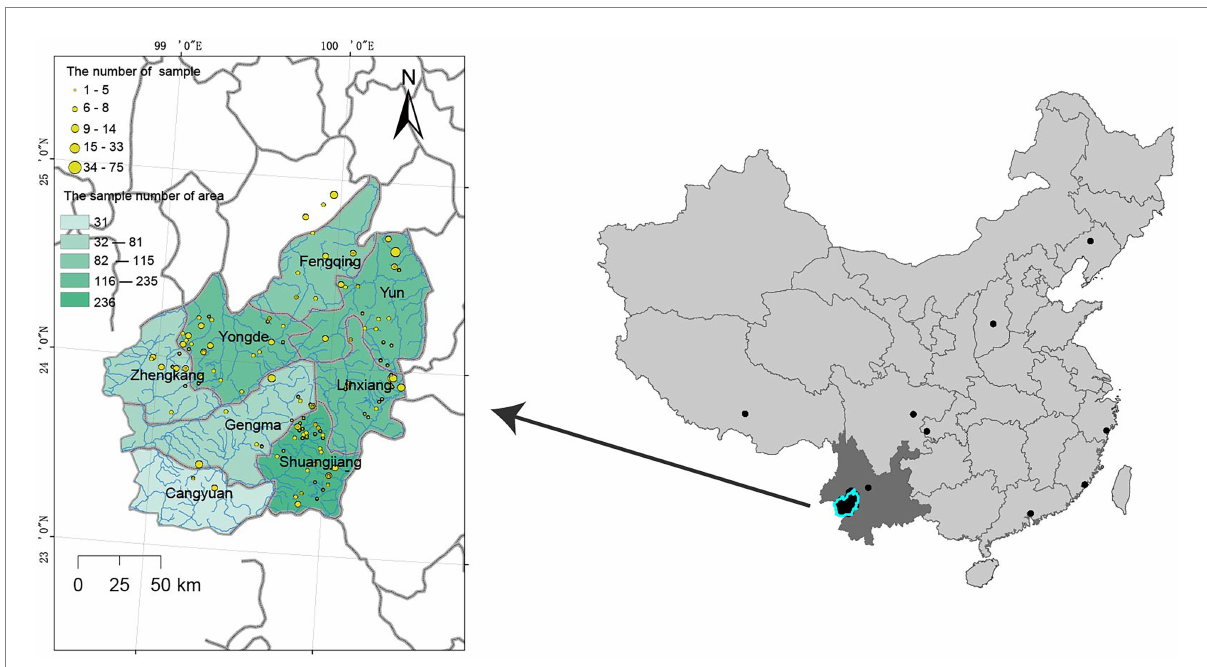
FIGURE 1 The geographical distribution of tea accessions was assessed in the present